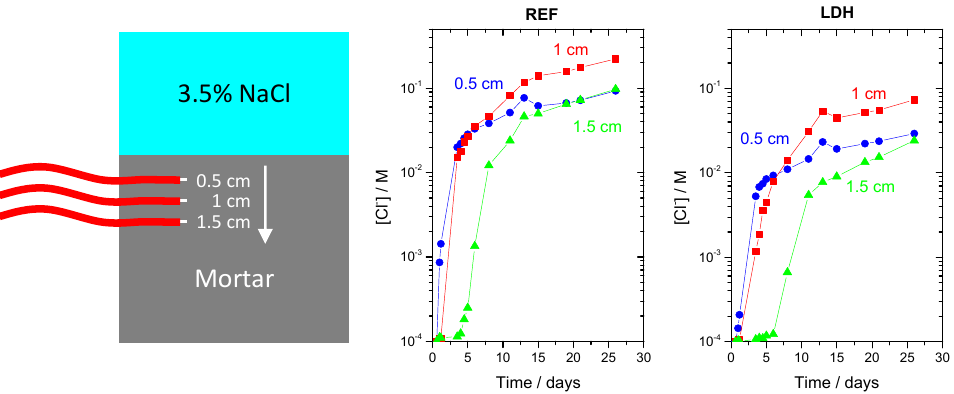
Figure 7. Scheme of mortar with sensors and chloride profiles inside mortar without (REF) and with ZnAl-NO 2 .